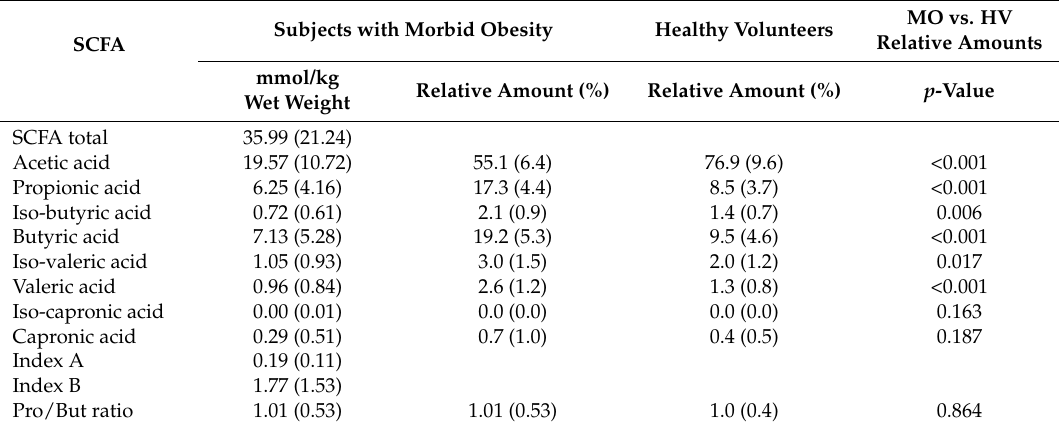
MO vs. HV Relative